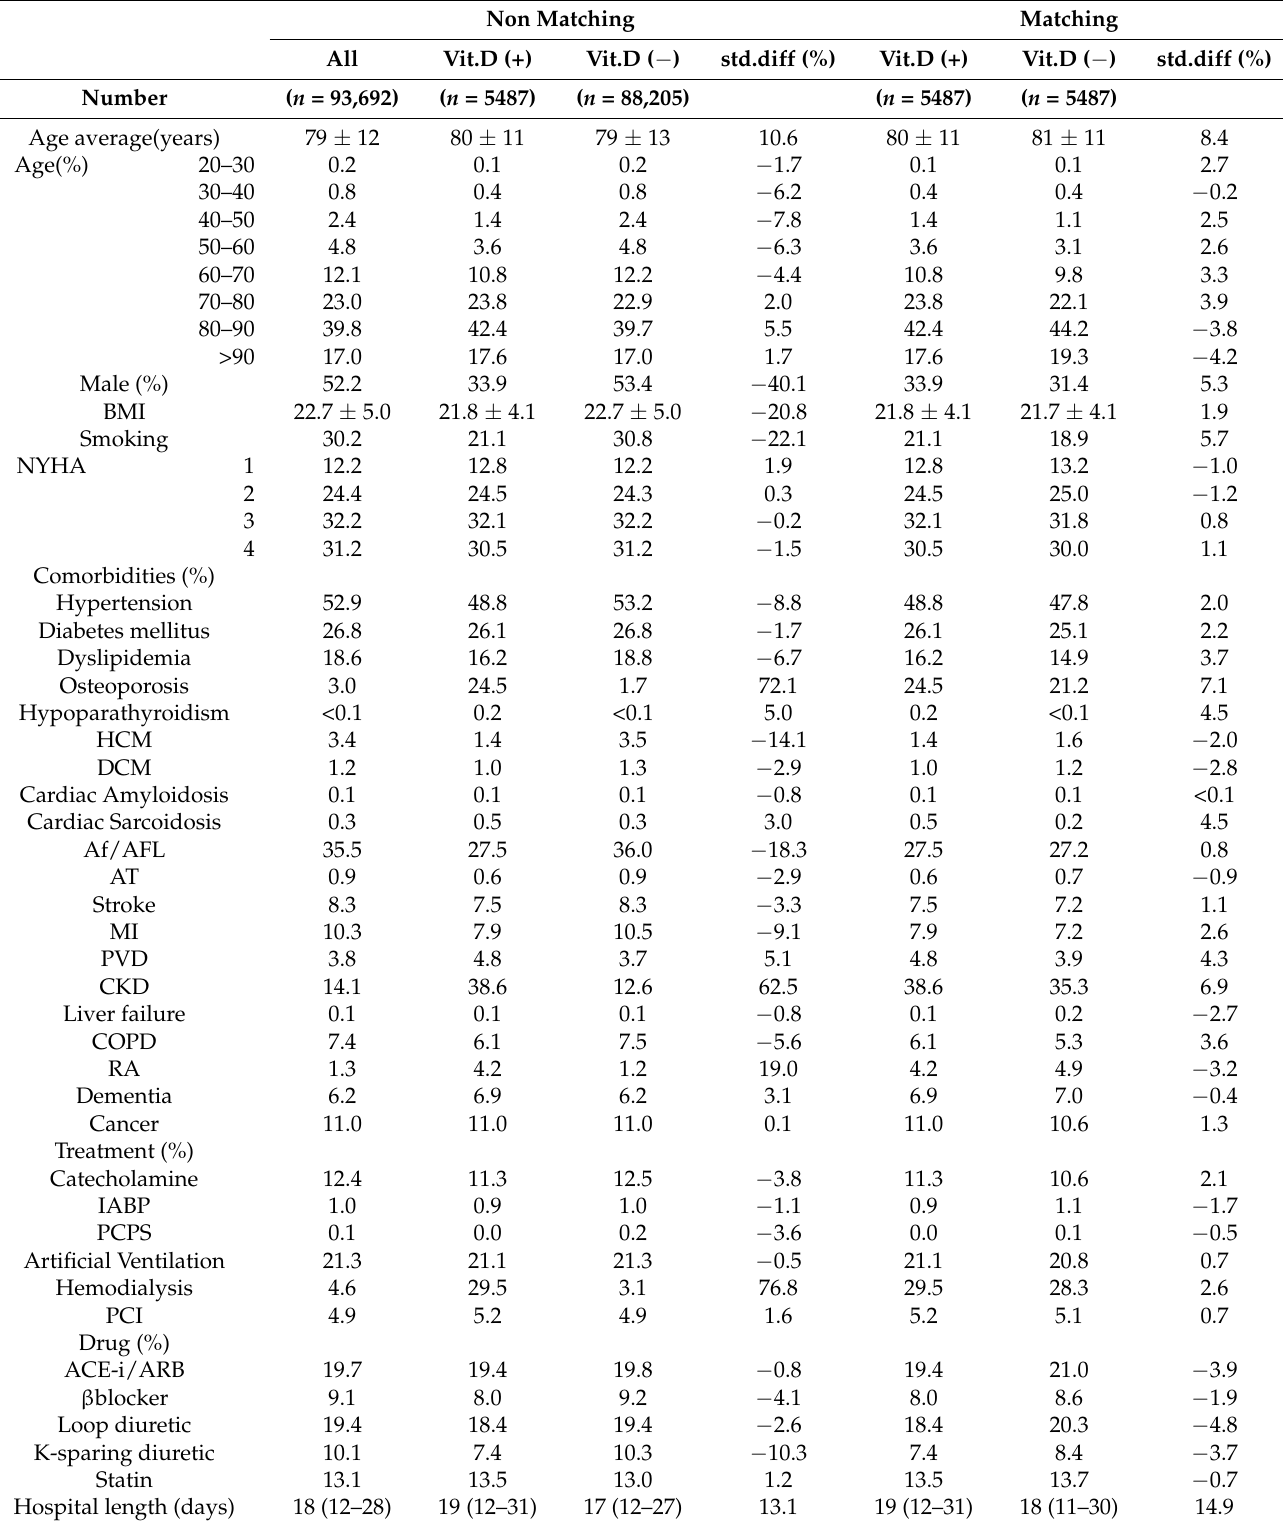
Table 1. Baseline characteristics before and after propensity score